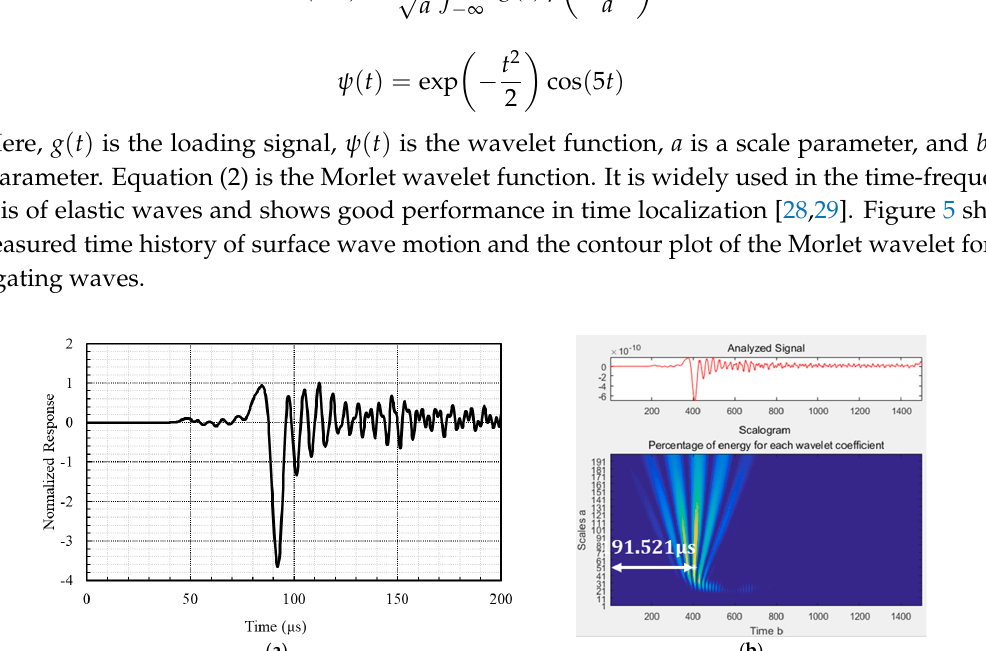
Figure 5. Measured time history of surface wave motion and the contour plot of the Morlet wavelet